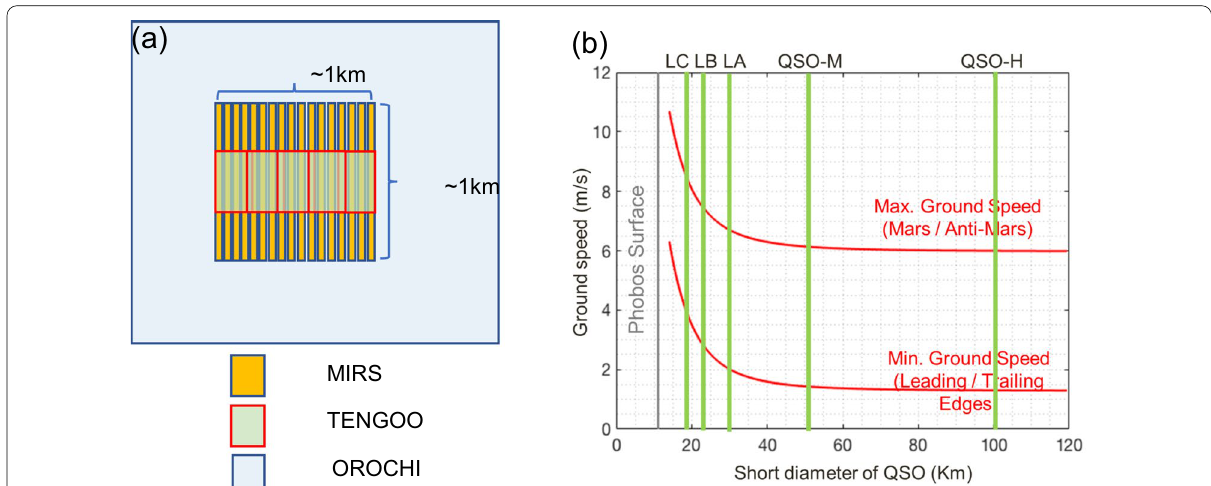
Fig. 8 a Conceptual diagram showing field of views for the simultaneous observation of a landing site candidate from QSO‑LA by TENGOO, OROCHI, and MIRS (field of views are not in precise scale). The area of about 1 km 1 km will be observed continuously by TENGOO and MIRS, × and imaged once by OROCHI, and the north–south areas not covered by TENGOO will be imaged in another rotations. b The maximum and the minimum ground speed of Phobos surface relative to the spacecraft at various QSOs. The maximum speed is achieved when the spacecraft is at sub‑Mars and anti‑Mars position, while the minimum speed is at leading and trailing position